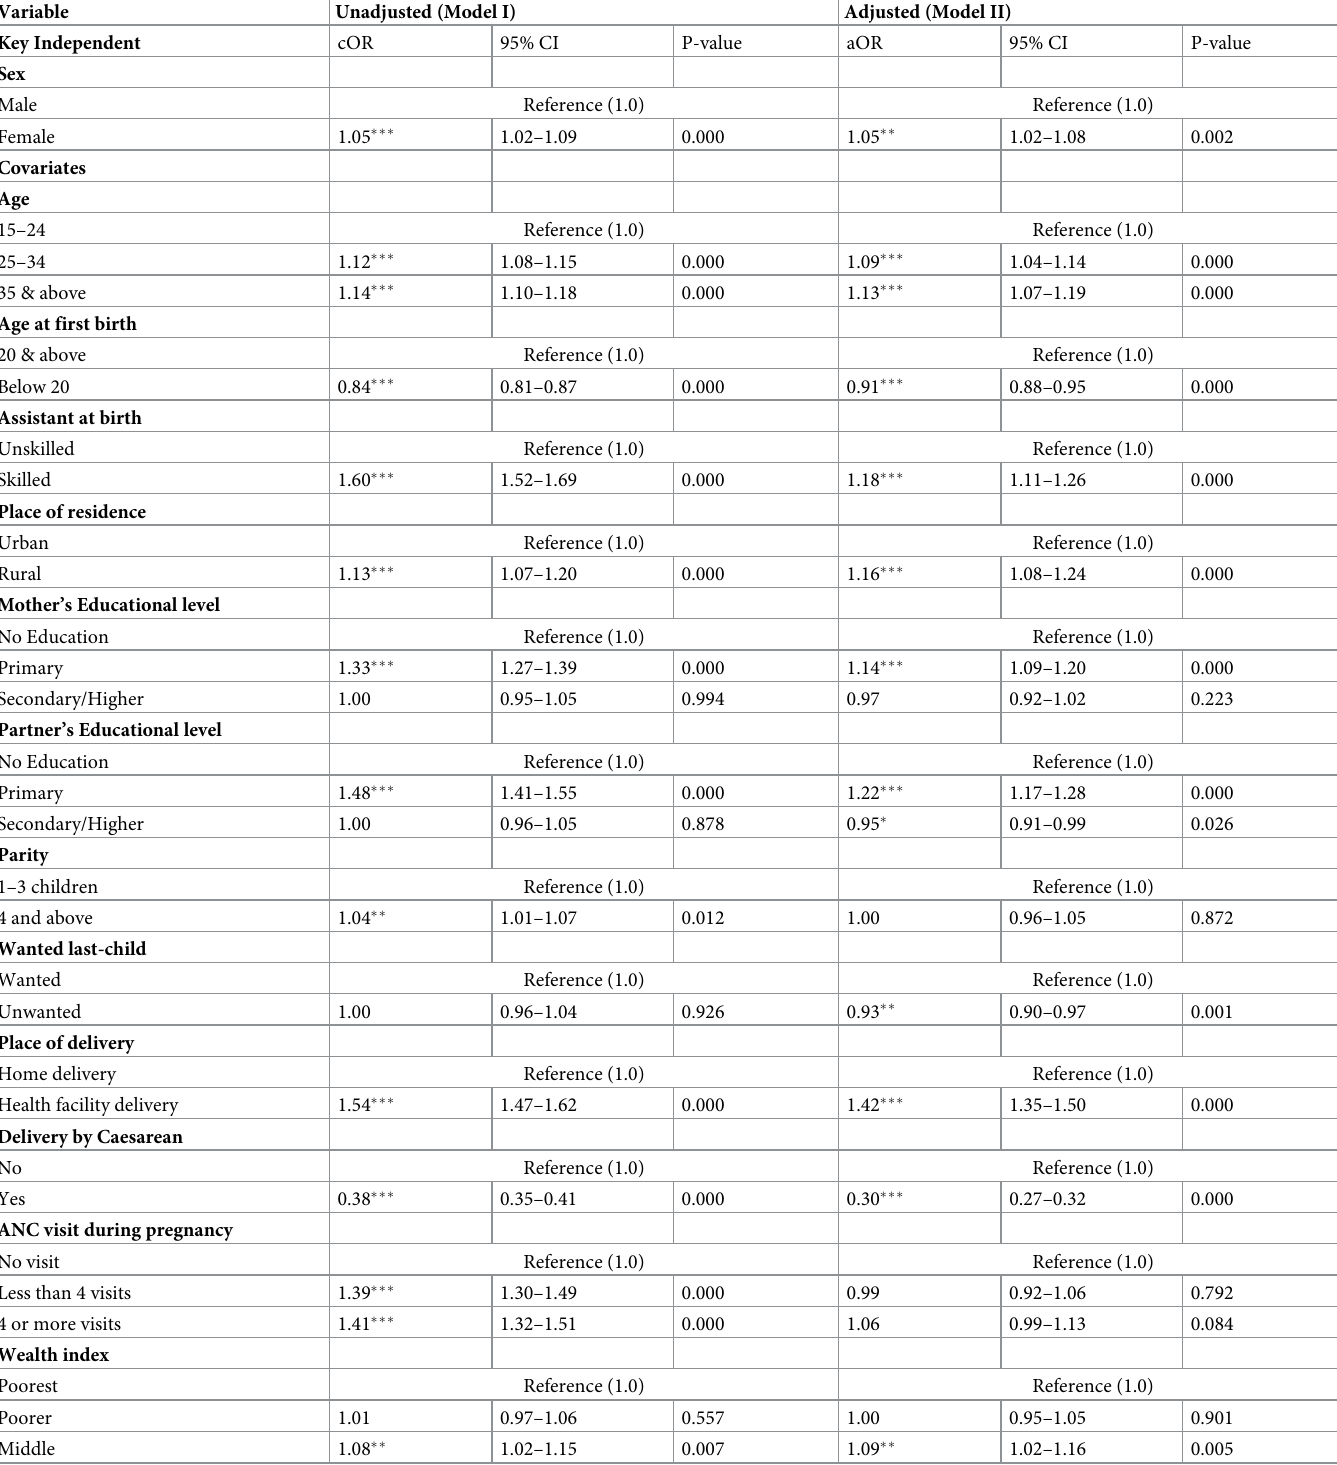
Table 3. Bivariate and multivariable models showing the effect of sex of the child, selected covariates, and early initiation of breastfeeding among women in sub- Saharan African